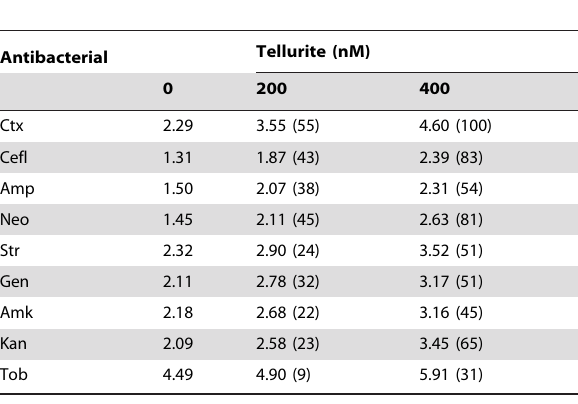
Table 1. Tellurite-mediated antibiotic-potentiating effect in clinical